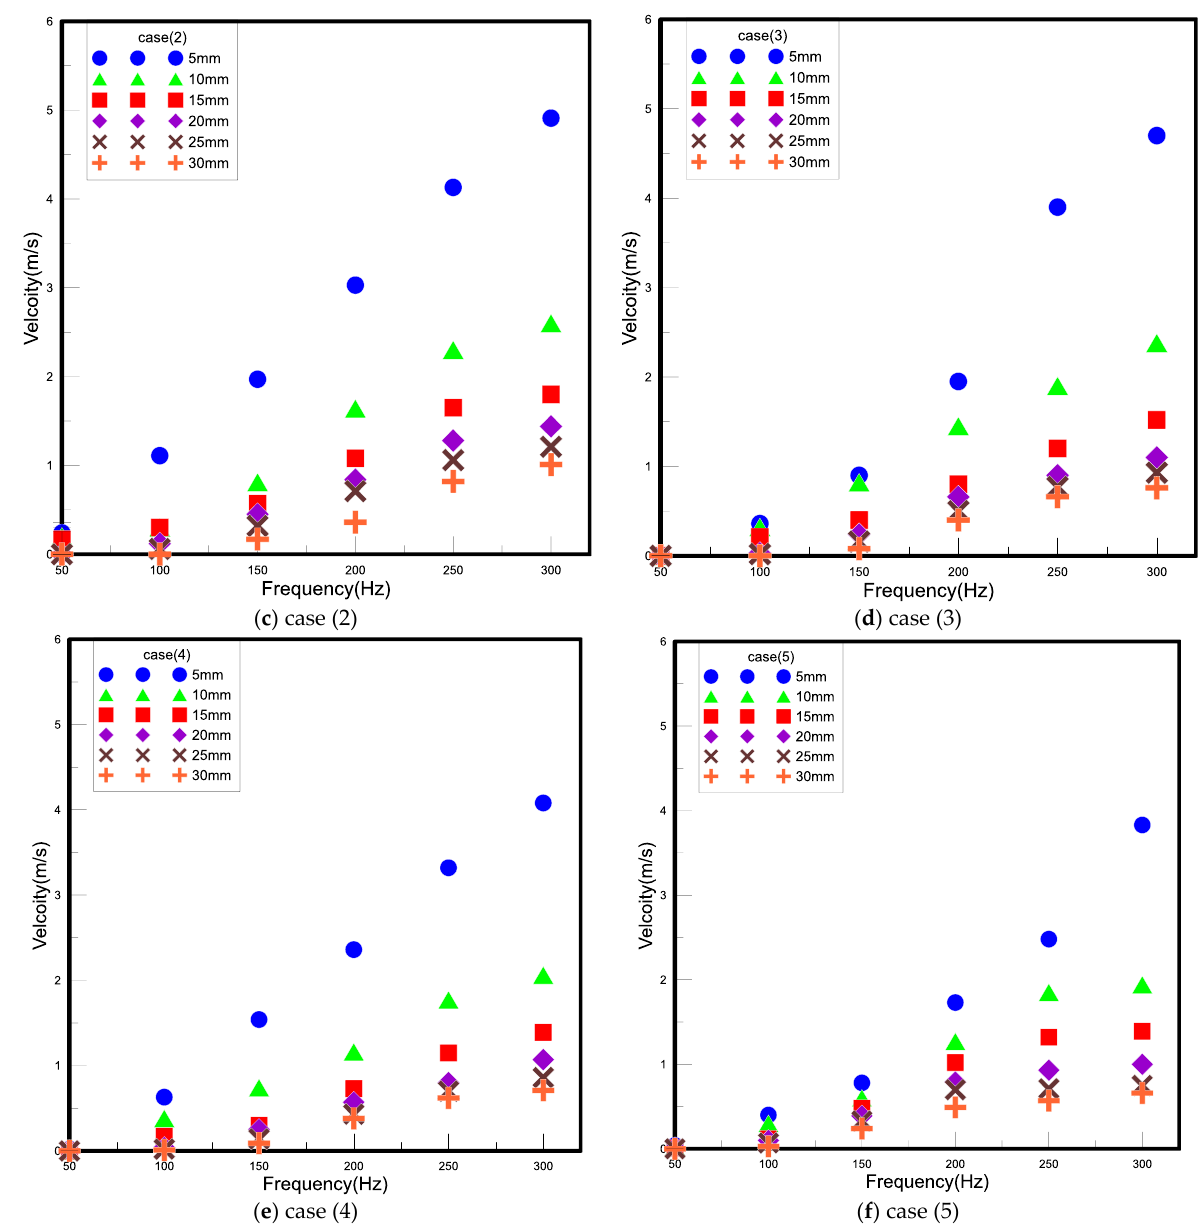
Figure 11. Each device when the wind speed and placement diagrams are under different frequencies.